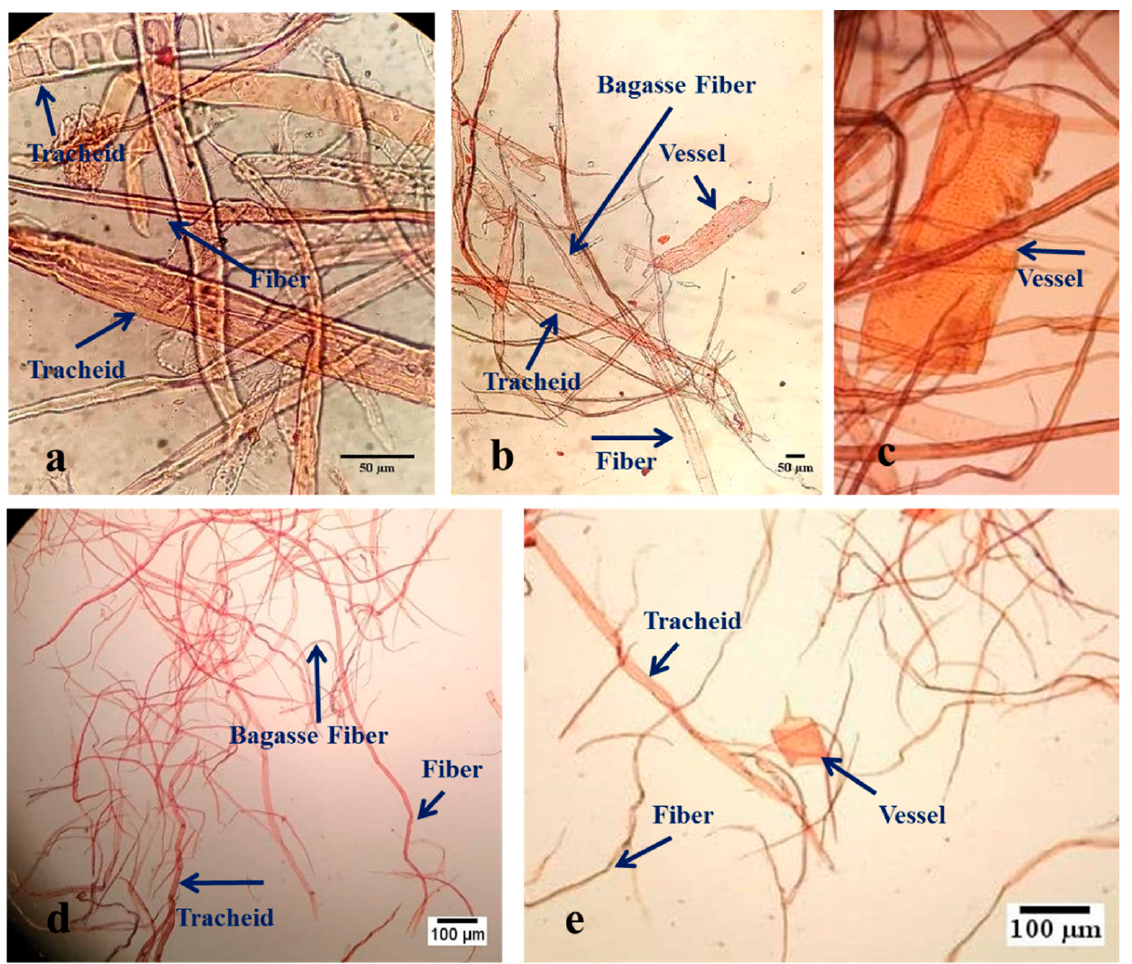
Figure 1. Manufactured fluff pulp with different formulations, 70S30H ( a , e ), 50S15H35B ( b , d ), 50S50H ( c ). SEM images of fluff pulp with 50S15H35B formulations are shown in Figure 2a,b. The uniform combination of all three components, softwood pulp, hardwood pulp and bagasse pulp, was evident in the fluff pulp. Figure 2c demonstrates the diameter of the fibers. In this figure, the presence of softwood fibers, with an average diameter of 30 µ m, hardwood pulp with an average diameter of 20 µ m and bagasse fibers with an average diameter of fibers with uniform distribution. The bentonite particle size located on the surface of fibers ranged from 9 to 32 µ